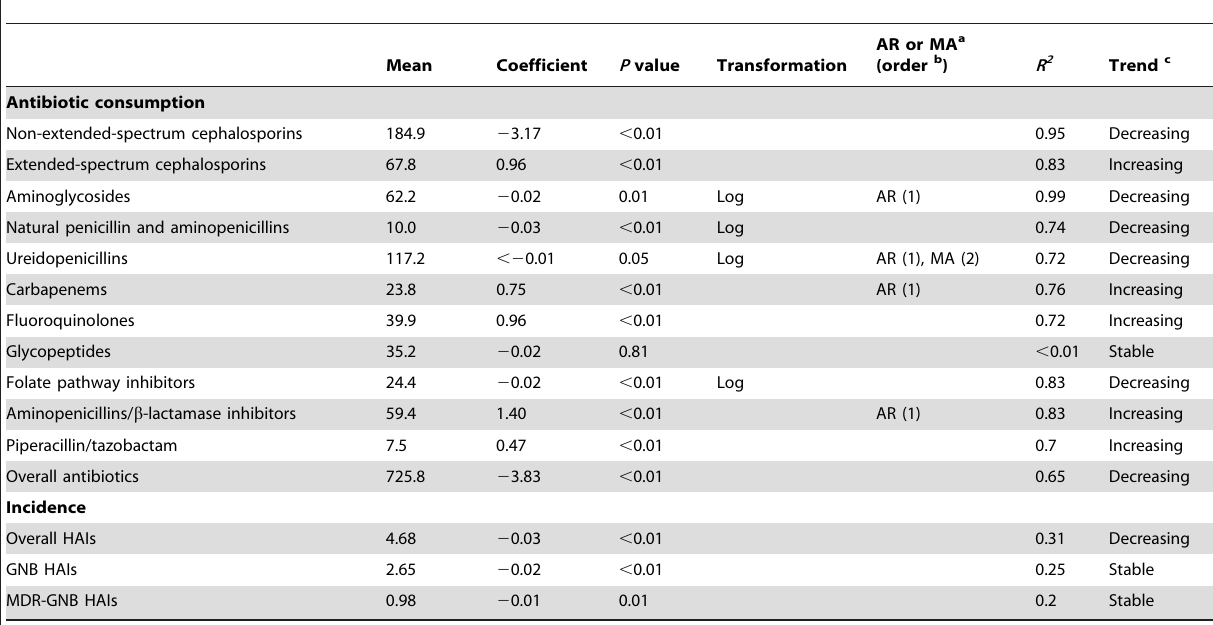
Table 1. Trends in antibiotic consumption (DDD/1,000 inpatient-days/quarter) and incidences of healthcare-associated infections (events/1,000 inpatient-days/ quarter) from 2002 to 2009 at KSCGMH.